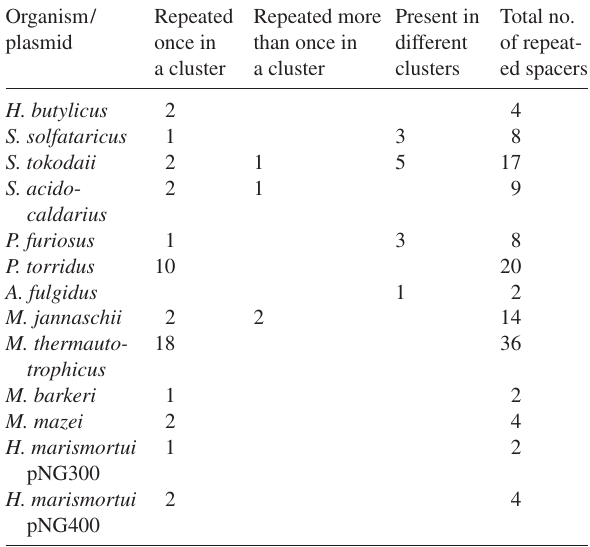
Table 3. Spacer sequences repeated either within a cluster or between different clusters of the same